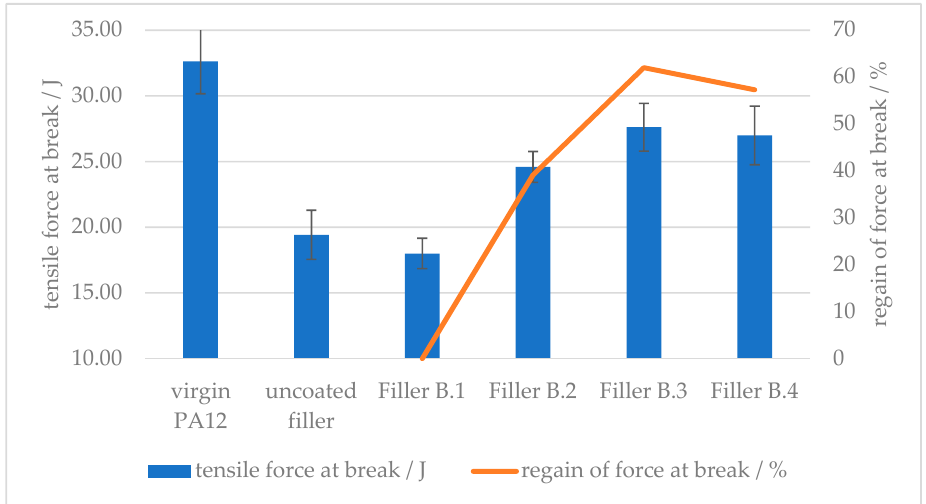
Figure 12. Effect of the amount of surface modifier on the tensile elongation at the break of amino hexanoic acid-treated, CaCO 3 -filled PA12 composites.